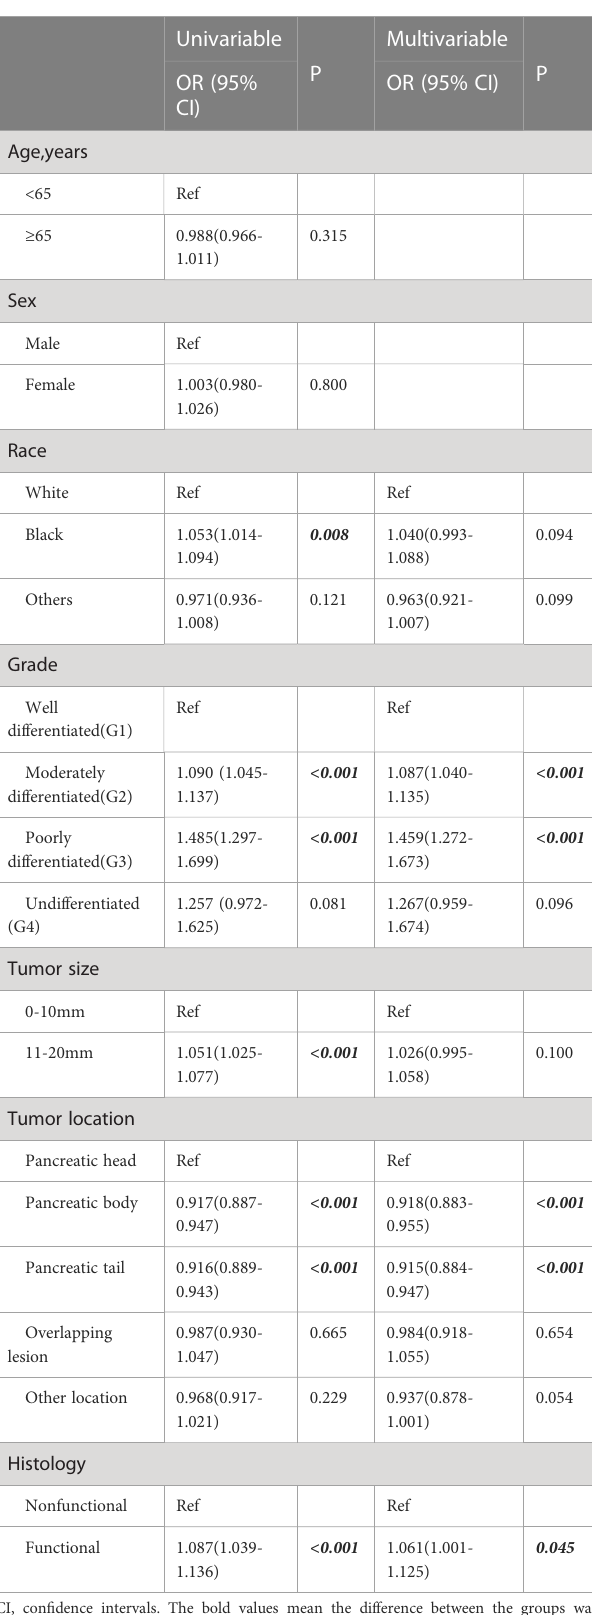
TABLE 3 Logistic regression analysis of clinicopathological factors associated with regional